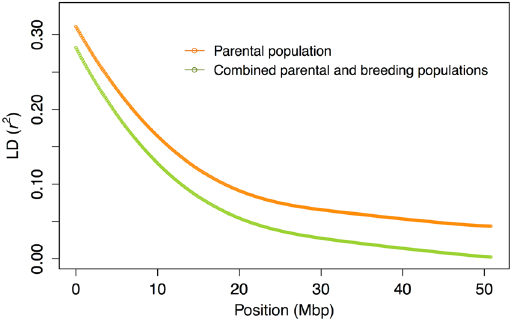
Figure 1. Linkage disequilibrium (LD) values ( r 2 ) between pairs of SNPs plotted against physical distances between markers. Curves show local polynomial smoothed plots with kernel weight for the parental population (n = 111) and combined parental and breeding populations (n =